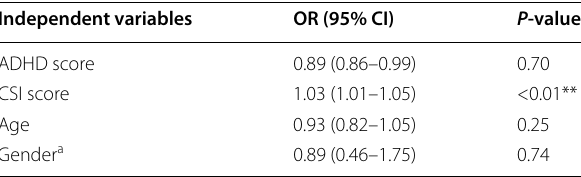
Table 6 Logistic regression model to test the effect of attention deficit hyperactivity disorder on back pain in the presence of central